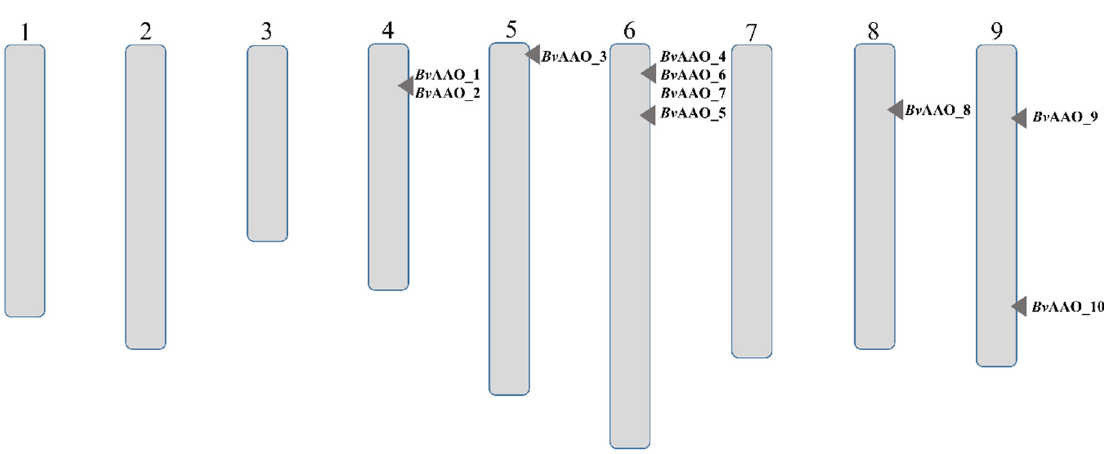
Figure 1. Chromosomal positions of AAO genes in Beta vulgaris